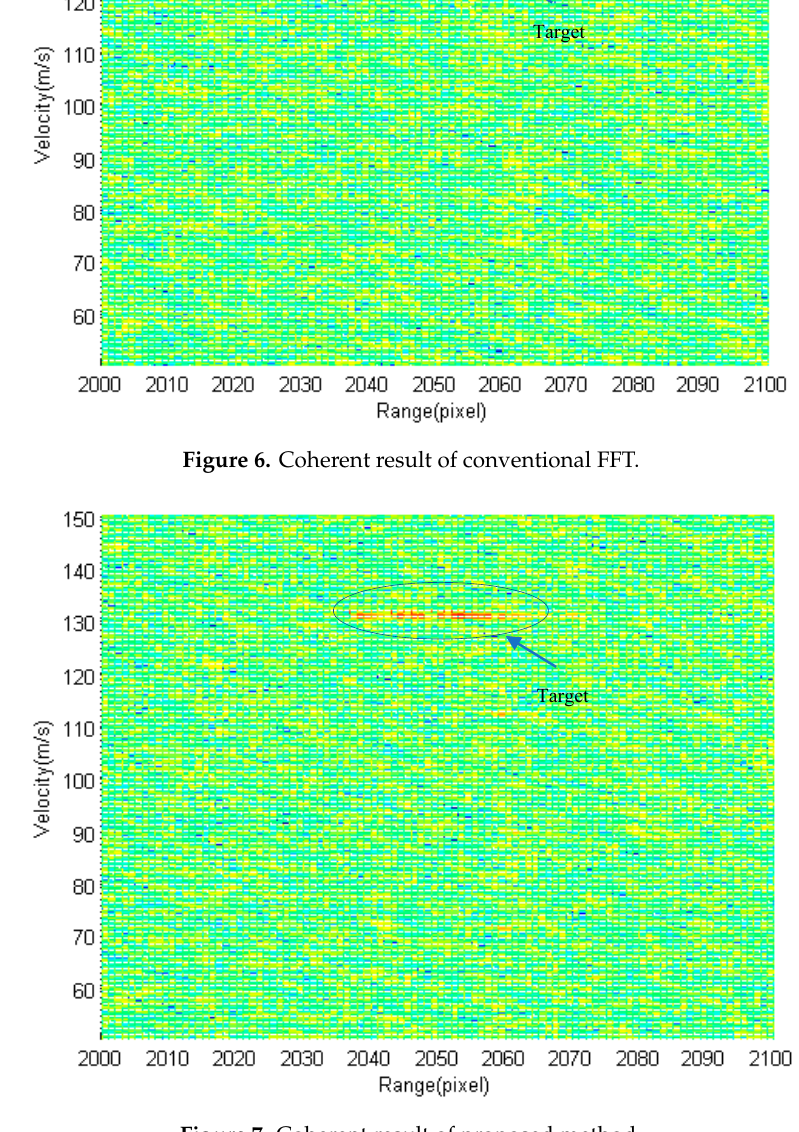
Figure 7. Coherent result of proposed method.